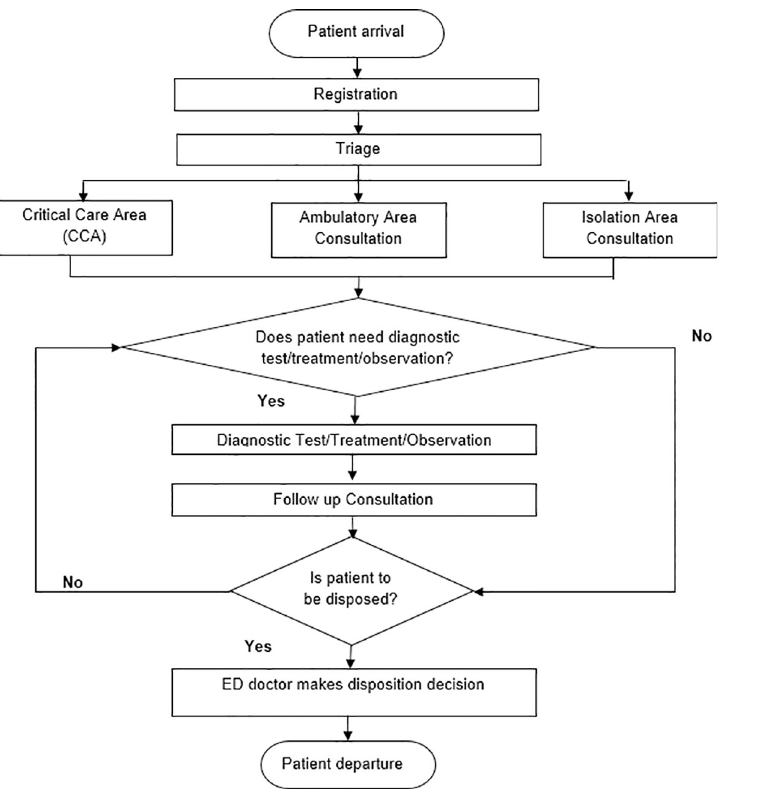
Fig 3. Overall structure of patient processing in a hospital-based ED in